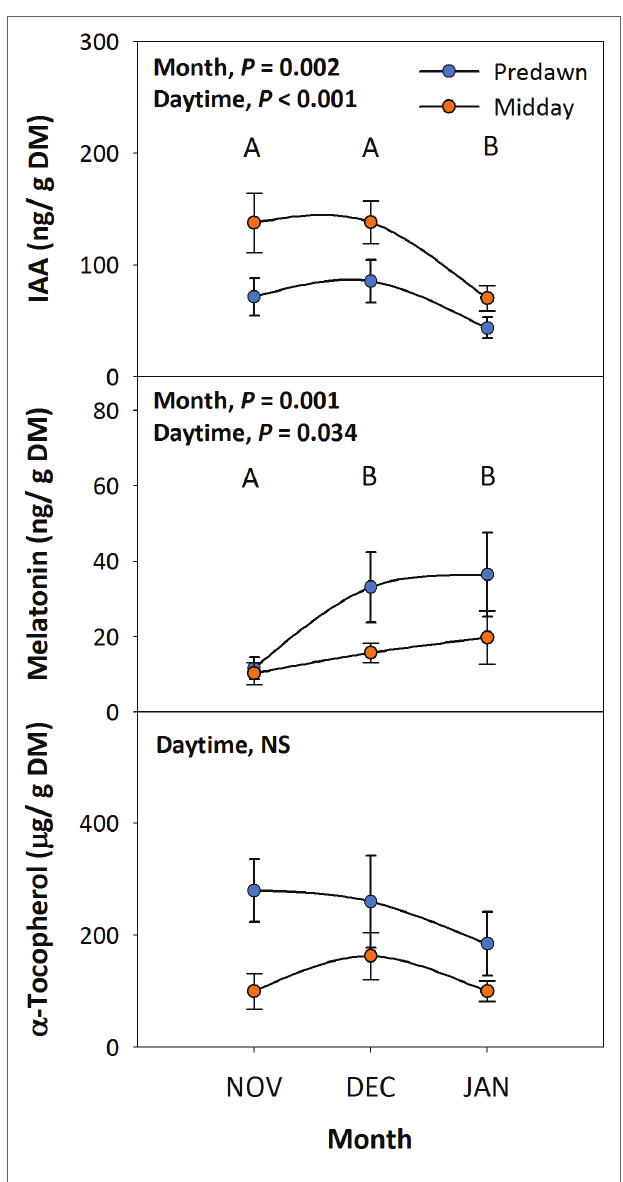
FIGURE 2 | Diurnal and seasonal changes in endogenous melatonin contents in the Mediterranean shrub, C. albidus . A comparison between melatonin contents relative to those of the biosynthesis-related phytohormone auxin and the well-known chloroplastic antioxidant α -tocopherol between predawn and midday from autumn (November) to winter (January) in plants growing at the experimental garden of the University of Barcelona is shown. Data correspond to leaf position 2 from the apex (see photograph in Figure 3 for details) and represent the mean ± SE of n = 6 individuals. After model selection, significant differences in “Month” and “Daytime” were tested by conditional Fisher tests ( p ≤ 0.05). Different capital letters indicate significant differences in Tukey’s HSD multiple comparison test ( p ≤ 0.05) with all data. Asterisks indicate significant differences in Tukey’s HSD multiple comparison test in “Daytime” within “Month”. NS, not significant; DM, dry